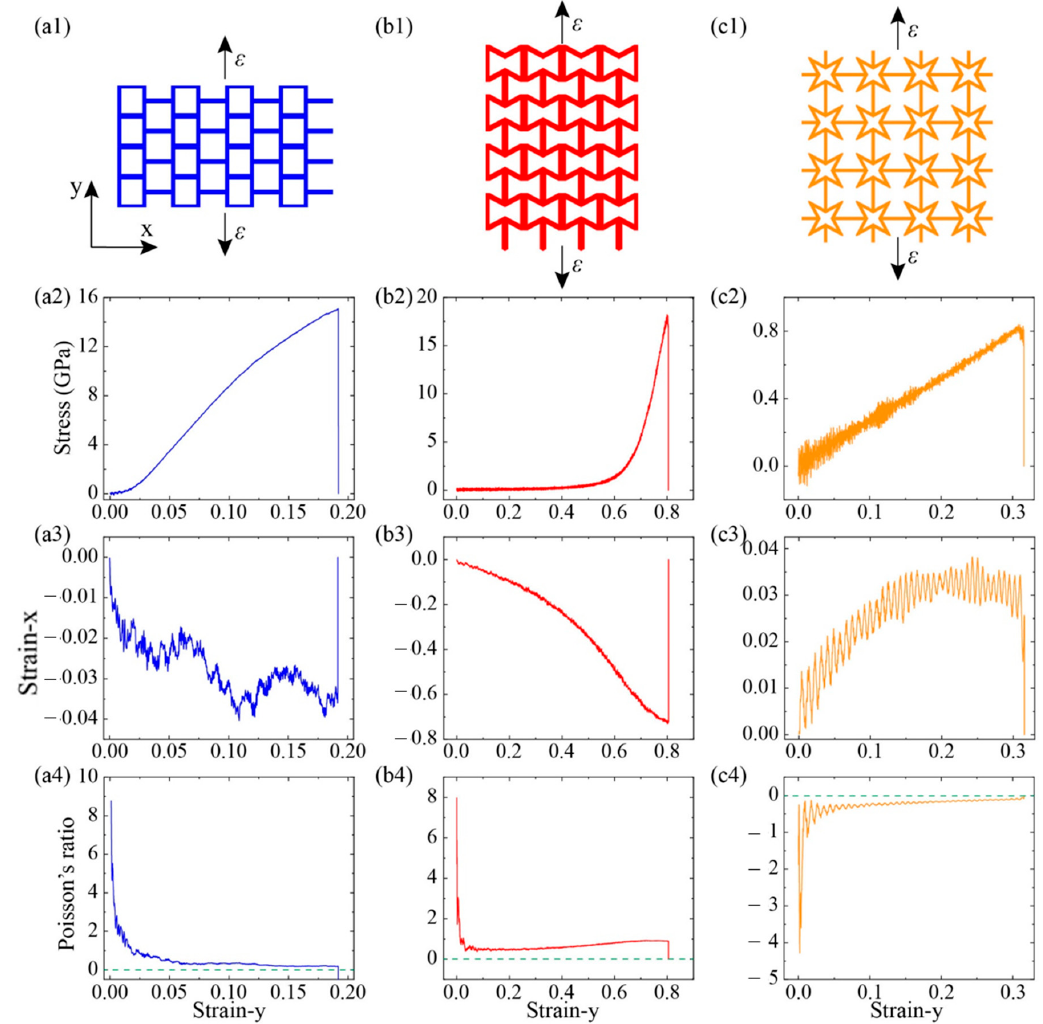
Figure 6. Mechanical properties of three KGSs are explored by conducting tensile loading along the y-direction ( a1 – c1 ). The relationships of stress–strain ( σ – ε ) ( a2 – c2 ), strain–strain ( ε x – ε y ) ( a3 – c3 ), and Poisson’s ratio–strain ( v – ε ) ( a4 – c4 ) are plotted.